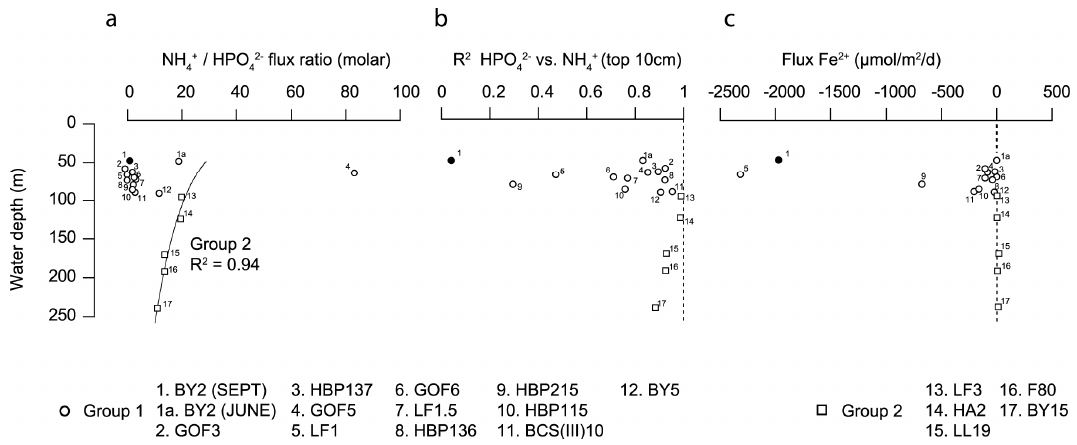
Fig. 3. (a) Ratio of diffusive fluxes of NH + /HPO − across the sediment-water interface vs. water depth for all sites. (b) Coefficient of 4 4 determination ( R 2 ) for linear regression between porewater profiles of NH + and HPO − in the uppermost 10cm of each core. Low R 2 4 4 indicates deviation of HPO − profile from asymptotic shape, caused by dissolution of Fe-P in surface sediments. Vertical dashed line 4 represents perfect correlation ( R 2 = 1). (c) Diffusive flux of Fe 2 + vs. water depth for all sites. Negative = efflux.